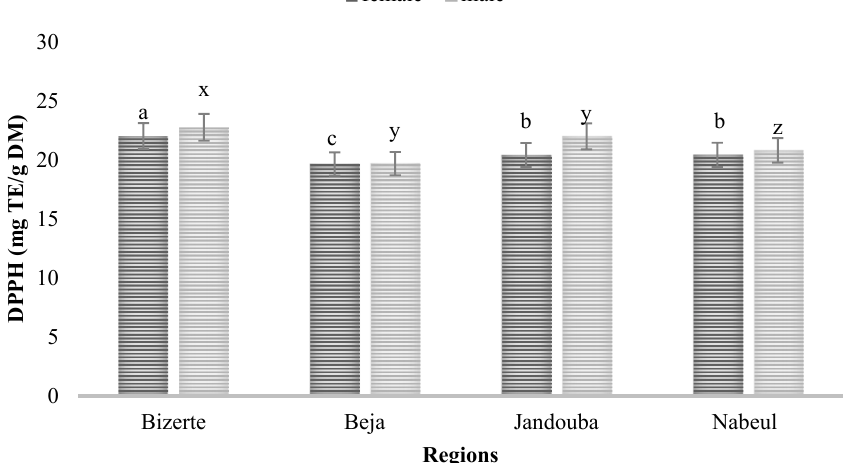
Figure 3. Antioxidant activity (DPPH) of leaves of male and female plants of M . annua from Bizerte, Beja, Jandouba and Nabeul provenances. Results of the Bonferroni test are significantly different at p < 0.05. Marked columns not linked by the same letter are significantly different at p < 0.05, and each data point is represented by the average of three repetitions ± SD.